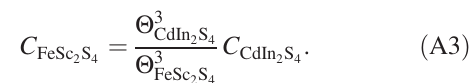
¯ d 32 (227) and the ¼ 5 . 59% Bragg